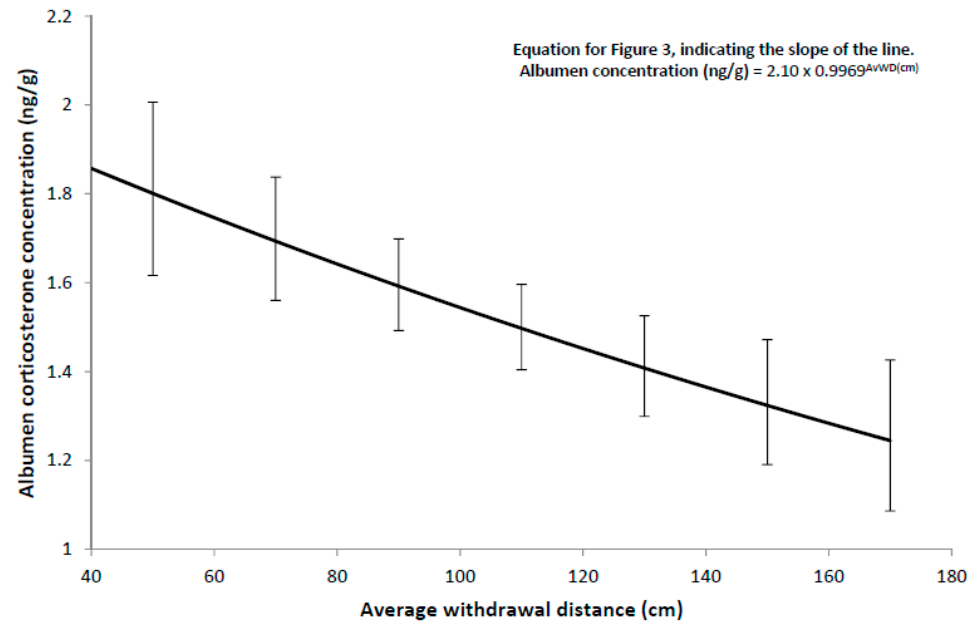
Figure 3. Relationship between albumen corticosterone concentration and the average withdrawal distance in the Stroll Test. Error bars represent 95% confidence intervals.